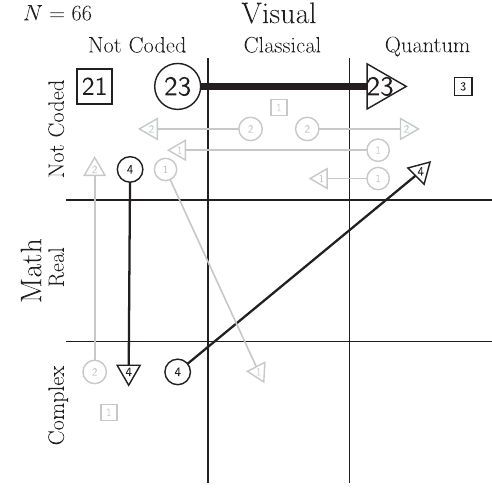
FIG. 6. Response transitions from pre- and midtest question 2a. FIG. 7. Response transitions from pre- and midtest question 2b.